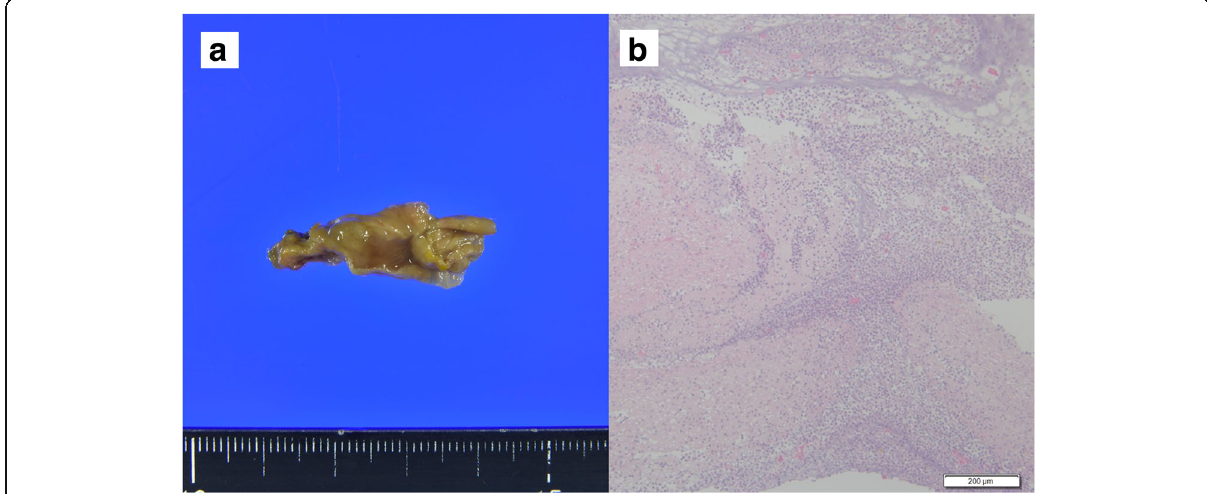
Fig. 7 The tumor was yellow tone, measuring 3 × 1 × 0.7 cm ( a ). Histological findings HE × 40: most of the tissue was fibrin thrombus, and a